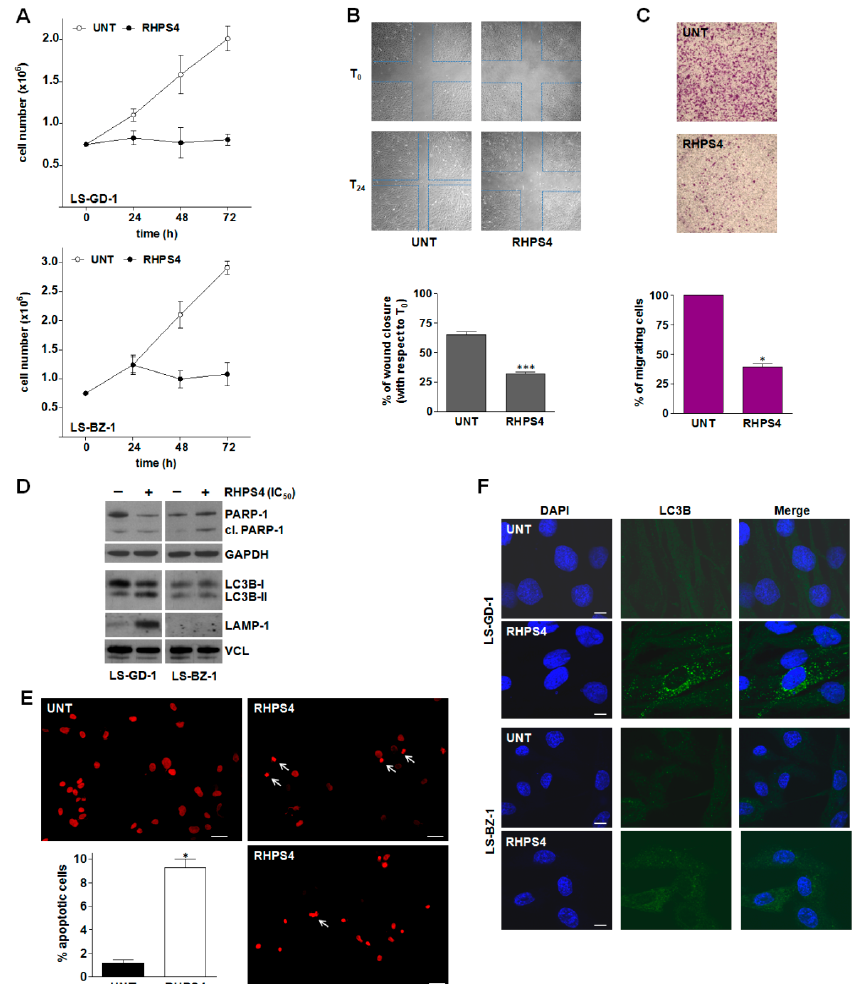
Figure 4. RHPS4-mediated biological effects on DDLPS cells. ( A ) Growth kinetics of untreated (o) and RHPS4-treated ( ● ) LS-GD-1 (top) and LS-BZ-1 (bottom) cells. Data have been reported as the number of growing cells and represent mean values ± s.d. from at least three independent experiments. ( B ) Representative images of a wound-healing assay showing the migration of untreated and RHPS4-treated LS-GD-1 cells at T 0 and T 24 (see material and methods); magnification × 4. The quantification of wound closure after 24-h exposure to RHPS4 (IC 50 ) has been reported in the graph on the bottom. Data have been reported as the percentage of wound closure at T 24 vs. T 0 and represent mean values ± s.d. from at least three independent measurements; *** p < 0.001). ( C ) Representative image of cell migration assessed at 24 h by a transwell assay in untreated and RHPS4-treated LS-GD-1 cells, magnification × 4. The graph on the bottom reports the quantification of migrating cells. Data have been reported as percentage of migrating cells in RHPS4-treated vs. untreated cells and represent mean values ± s.d. from at least three independent experiments; * p < 0.05). ( D ) Representative Western immunoblotting showing the amounts of the indicated proteins in untreated ( − ) DDLPS cells and after 72-h exposure to an equitoxic concentration of RHPS4 (+). GAPDH and Vinculin (VCL) were used to ensure equal protein loading. Cropped images of selected proteins are shown. For the original, uncropped blots/gels see File S1. ( E ) Representative images of untreated and RHPS4-treated LS-BZ-1 cells stained with propidium iodide showing the apoptotic nuclear morphology at 72 h; scale bars: 50 µ m; magnification: × 20. The graph shows the quantification of apoptotic cells in the overall LS-BZ-1 cell population. Data have been reported as the percentage of apoptotic cells and represent mean values ± s.d. from at least three independent counts. * p < 0.05. ( F ) Representative images of fluorescence microscopy analysis of LC3B in untreated DDLPS cells and after 72-h exposure to RHPS4. Nuclei were counterstained with DAPI. Merged images are shown; scale bar: 10 µ